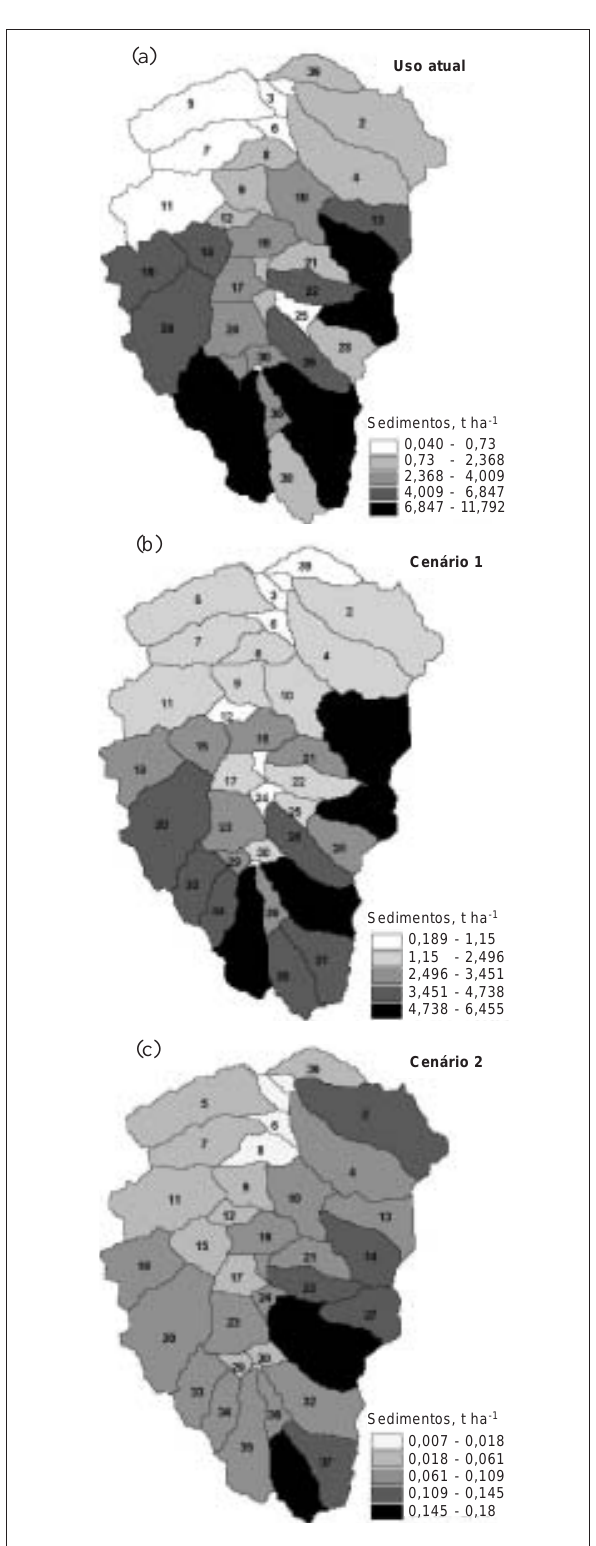
Figura 4. Distribuição espacial da produção de sedimentos no mês de janeiro de 1999, na microbacia hidrográfica do Ribeirão dos Marins, para os cenários: (a) uso atual; (b) cenário 1; (c) cenário